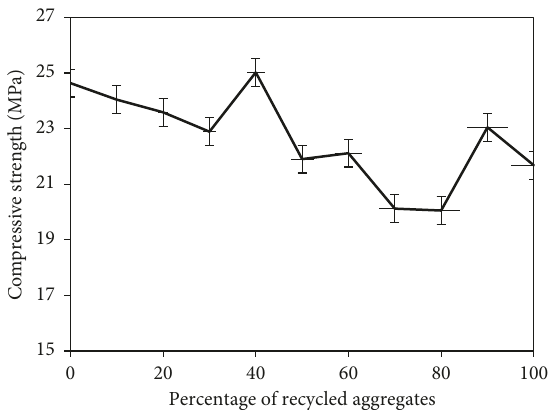
Figure 3: Compressive strength for all mixes after 28days.